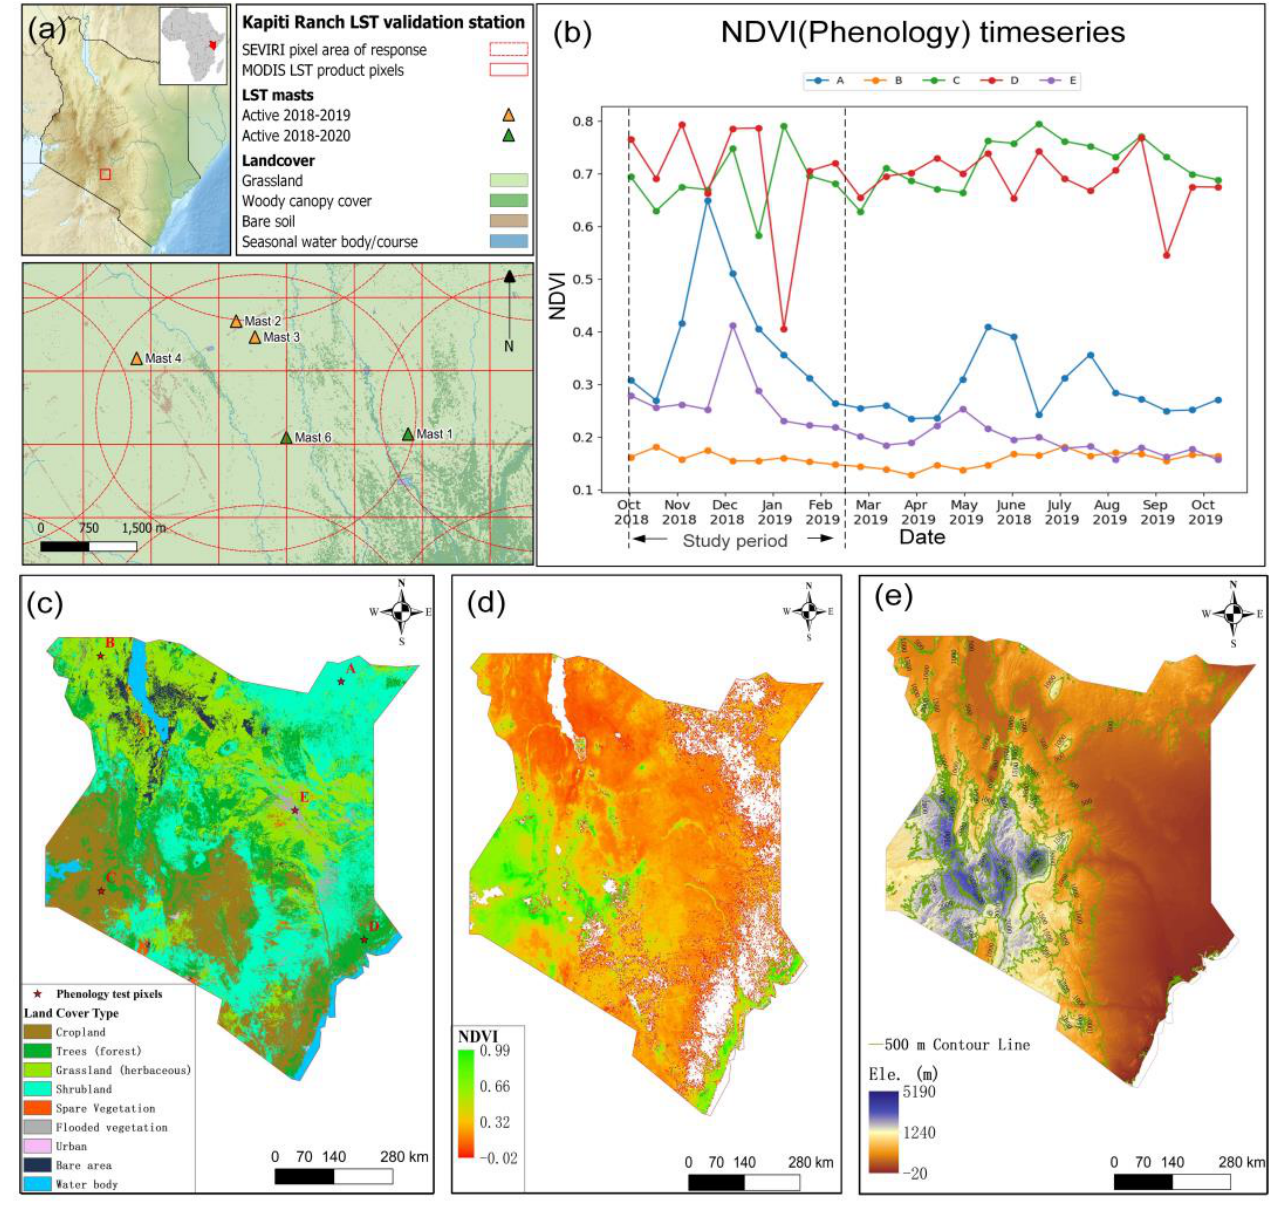
Figure 1. Location and geographical settings of the study area, Kenya- Eastern Africa, and the layout of in situ measurement sites located within the study area whose LST data records are used as validation data herein. ( a ) Upper left, Location of the ILRI Kapiti Research Station in Kenya and the location of the LST validation masts at Kapiti. Inset right- location of Kenya in Africa. Lower pane- Location of the four LST measurement mast sites at ILRI Kapiti Research Station with the approximate response area of the SEVIRI and MODIS pixels over the research station. ( b ) NDVI time series from MODIS MYD13A2 16-day composite product for five typical pixels (A, B, C, D, and E) across Kenya of an entire phenological year from October 2018 to September 2019. ( c ) A 300 m resolution land cover classification map of Kenya in 2018 produced by the European Space Agency (ESA) Climate Change Initiative (CCI); ( d ) An NDVI map of Kenya at 500 m resolution on 22 October 2018, calculated using MODIS MCD43A4 product. Pixels with NDVI < − 0.2 (which might indicate water) were screened out. ( e ) The resampled 1 km resolution map Digital Elevation Model (DEM) of Kenya, derived from the 90m NASA Shuttle Radar Topography Mission (SRTM) dataset (http://srtm.csi.cgiar.org accessed on 7 February